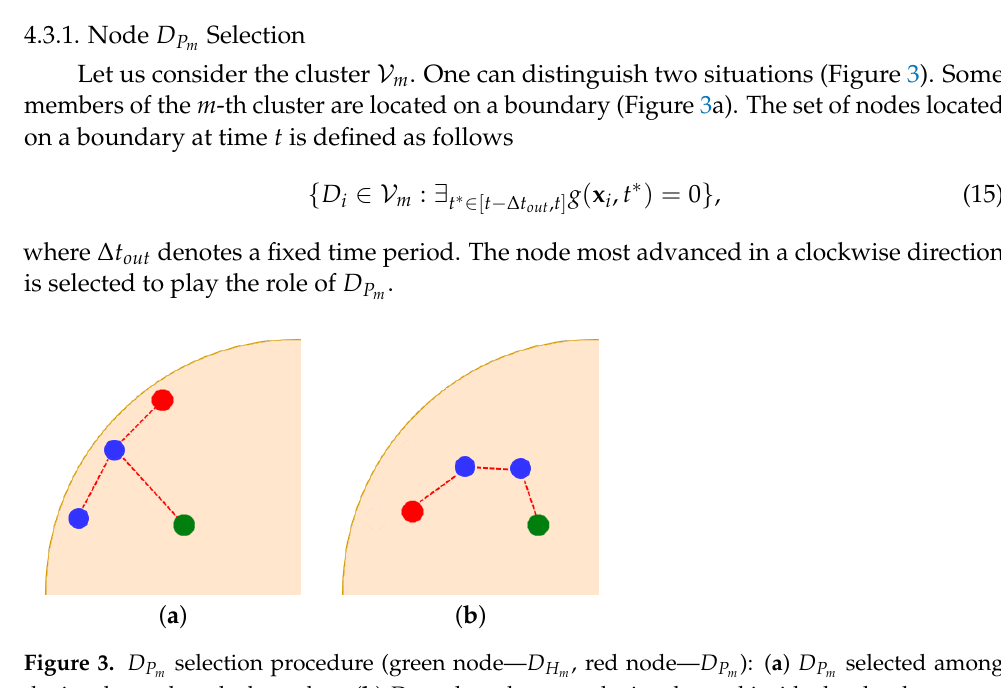
, red node— D P m selected among devices located inside the cloud. m